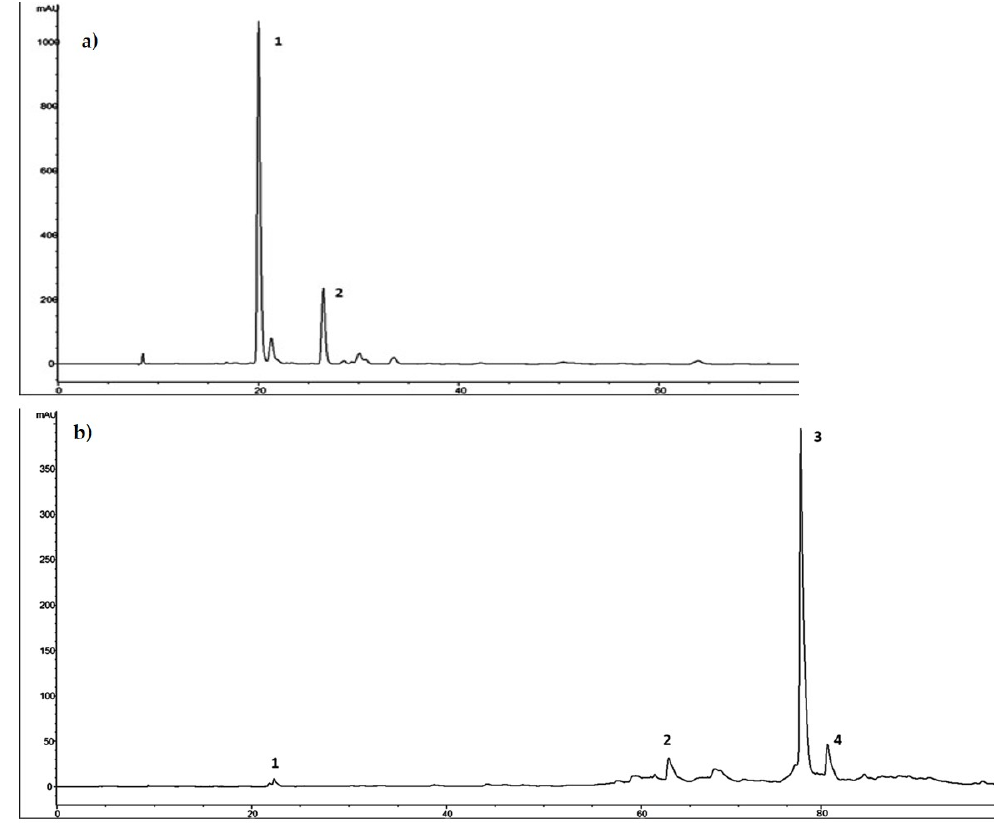
Figure 2. ( a ) Chromatographic profile of hydroxytyrosol-enriched extract (HTyrE) at 280 nm. 1. HTyr; 2. Tyrosol. ( b ) Chromatographic profile of oleuropein-enriched extract (OleE) at 280 nm. 1. HTyr; 2. verbascoside; 3. oleuropein; 4. secoiridoid derivative.